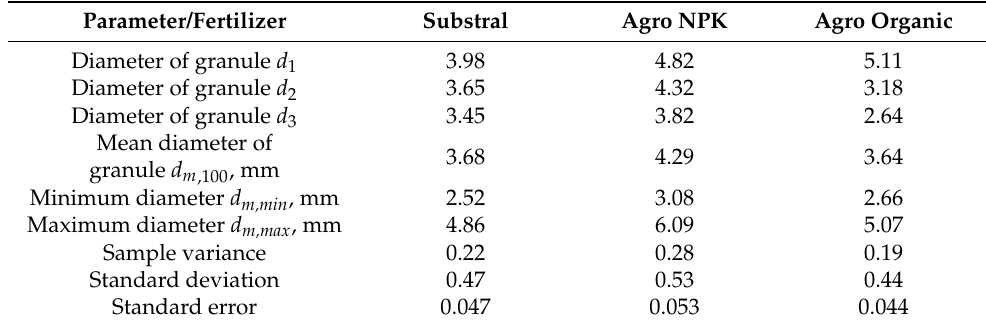
Table 2. Geometrical parameters of blueberry fertilizer granules. Parameter/Fertilizer